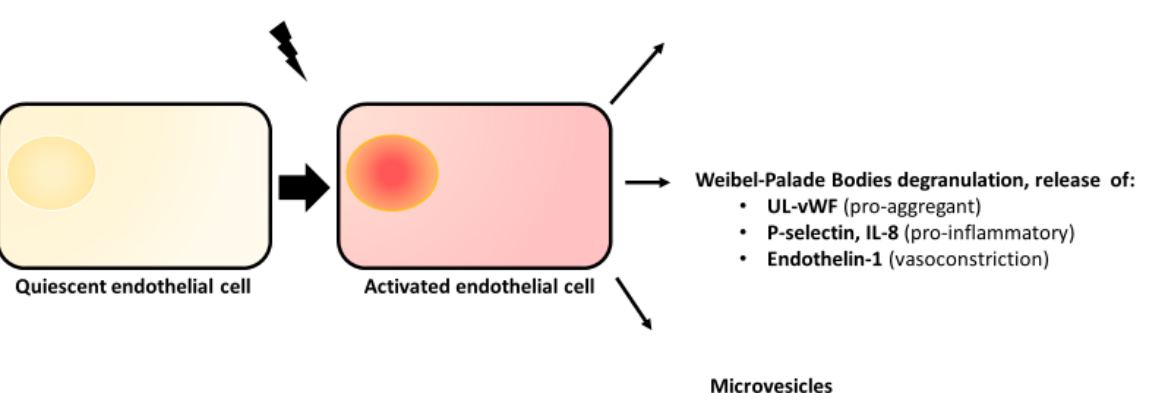
Figure 1. Consequences of endothelial cell activation. UL ‐ VWF = Ultralarge von Willebrand factor; IL ‐ 8 = Interleukin ‐ 8.